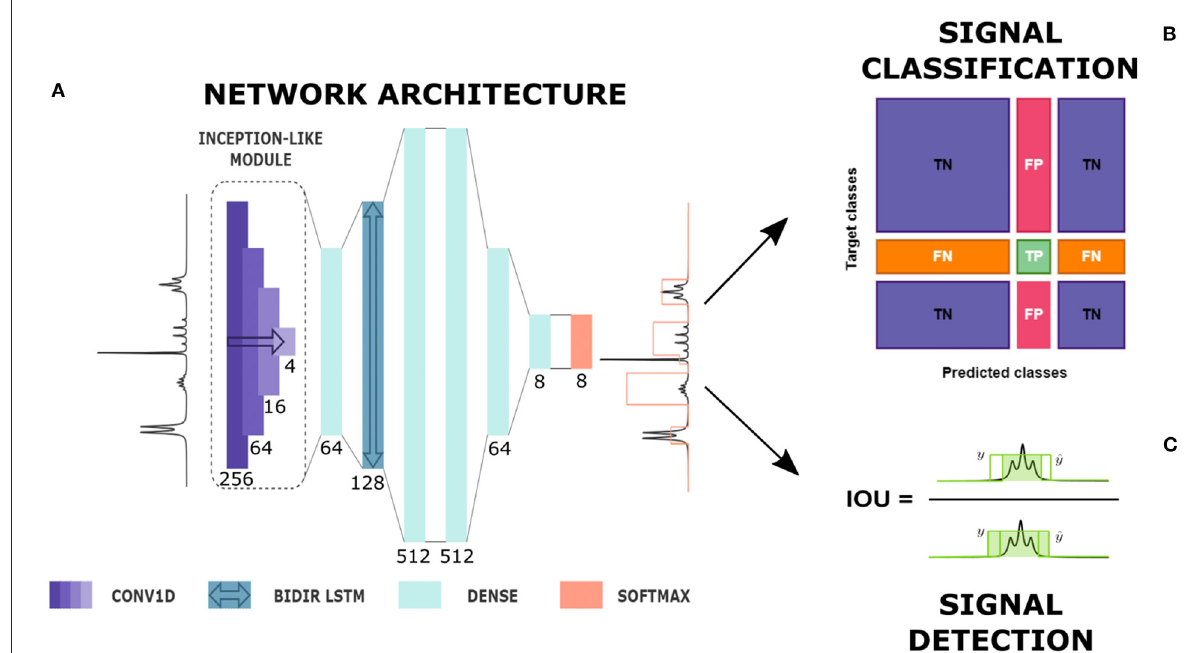
FIGURE1 From automatic prediction to analysis. (A) Diagram of network’s architecture. CONV1D is a one-dimensional convolutional layer, BIDIR LSTM is a bidirectional LSTM layer, DENSE is a time-distributed fully connected layer and SOFTMAX is the softmax output. Here, the type of each layer with its kernel size, in the case of convolutional layers, and number of units, in the case of fully connected and LSTM layers are given (see also Supplementary material). The network produces the prediction of a label whose height represents the multiplet class. (B) Signal classification. True Positives (TP), False Positives (FP), True Negatives (TN) and False Negatives (FN) definition for a given multiplet class based on the confusion matrix entries. (C) Signal detection: Intersection Over Union (IOU) definition in a 1D